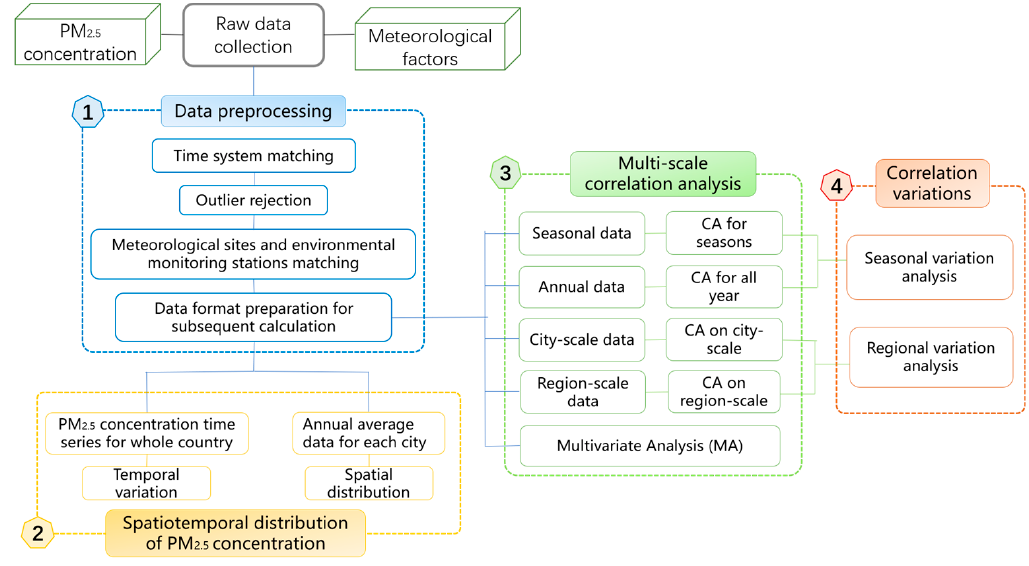
Figure 3. Flow chart of the study design.